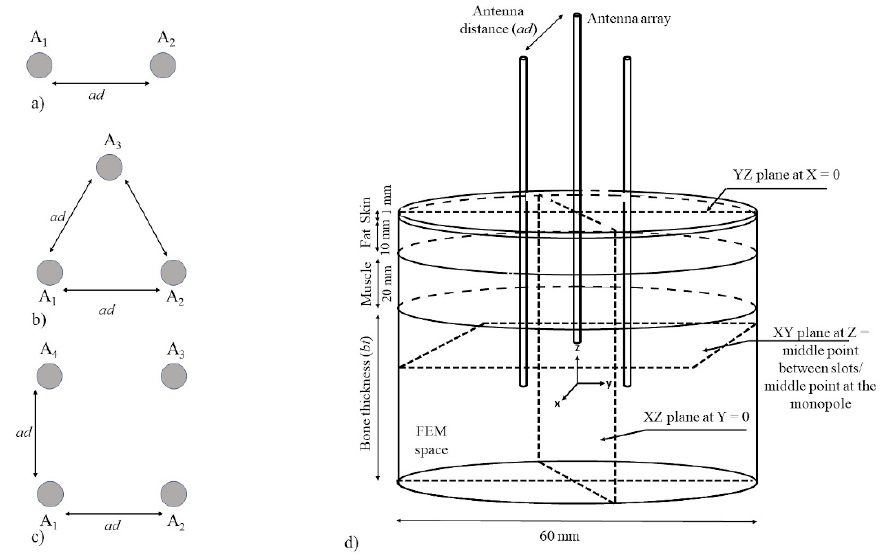
Figure 3. Proposed antenna array configurations to be analyzed, the antennas are depicted as A 1 A 2 , A 3 , and A 4 according to the antenna configuration, and example of the 3D computational model, ( a ) linear antenna array, ( b ) triangular antenna array, ( c ) square antenna array, and ( d ) example of the geometry that was used to implement this study. The geometry consists of a cylinder of multilayer tissue (bone, muscle, fat, and skin), as well as the evaluated antenna array. The thicknesses of muscle, fat, and skin were 2 cm, 1 cm, and 1 mm, respectively. The observation planes XY, XZ, and YZ that were used for the evaluation are also depicted. As previously described, the distance between antennas ( ad ) was modified from 1 mm to 15 mm and bone thickness ( bt ) from 2 to 4 cm.